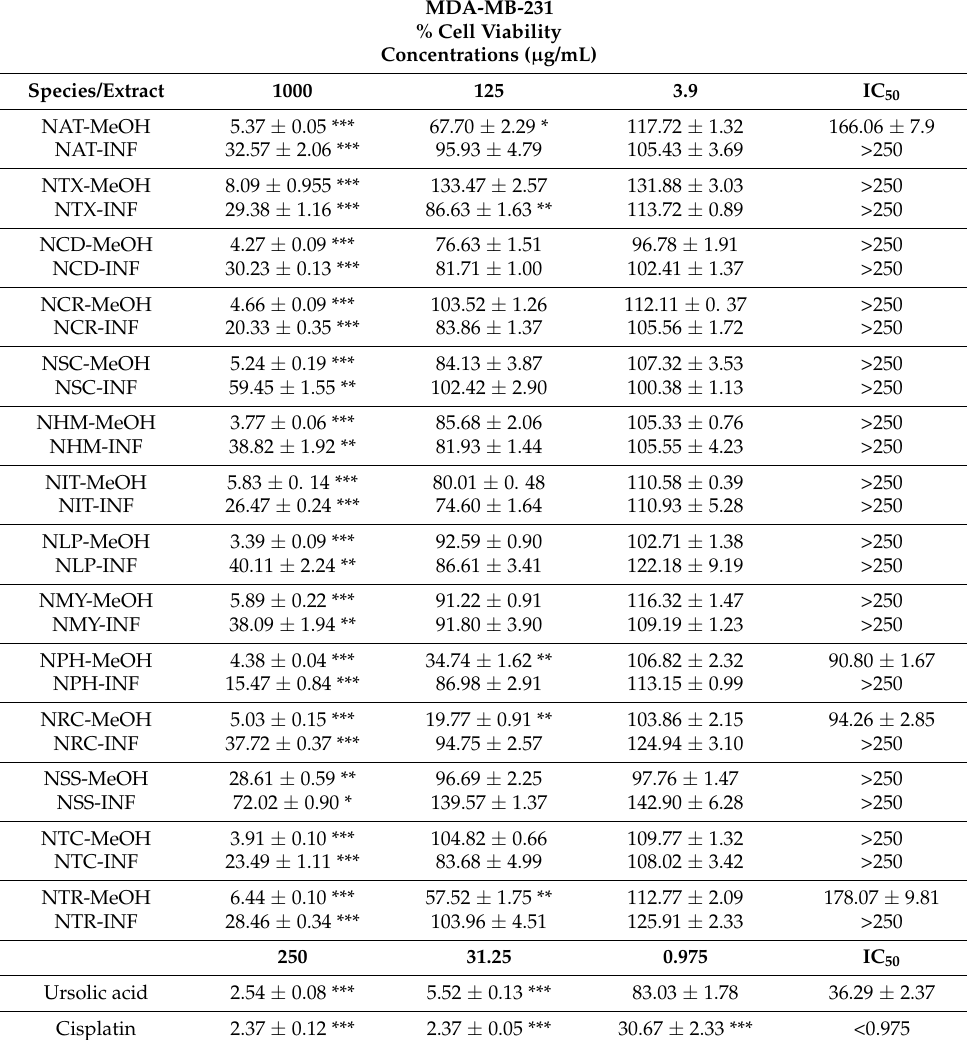
Table 3. Cytotoxic effects of Nepeta species on MDA-MB-231 cell